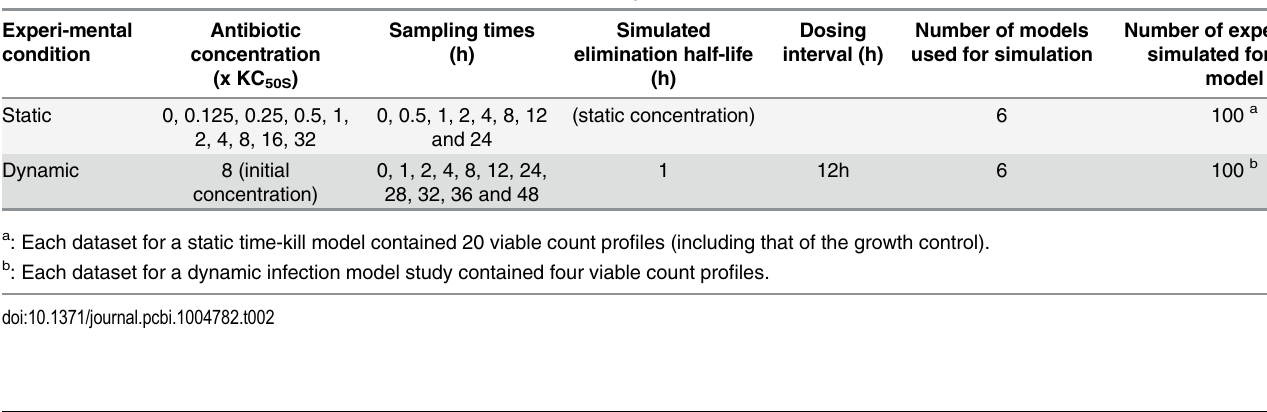
Simulated Dosing Number of models elimination half-life interval (h) used for simulation